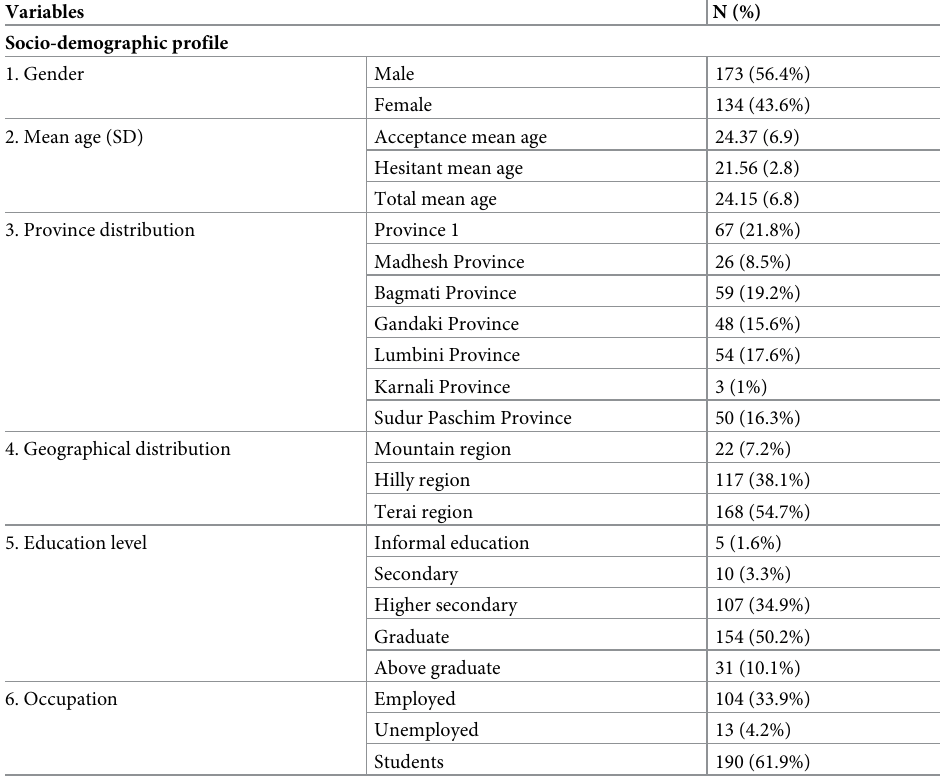
Table 1. Sociodemographic data of participants(n =